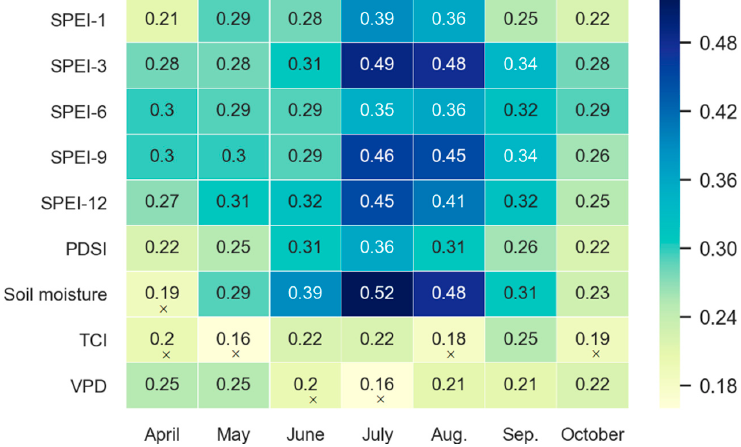
Figure 9. Comparison of the correlation coefficients between SIF and drought variables in each month of growing season for temperate grasslands. The symbol × represent significant correlations (0.01 < P < 0.05). The correlation without symbol × were significant at 1% level.